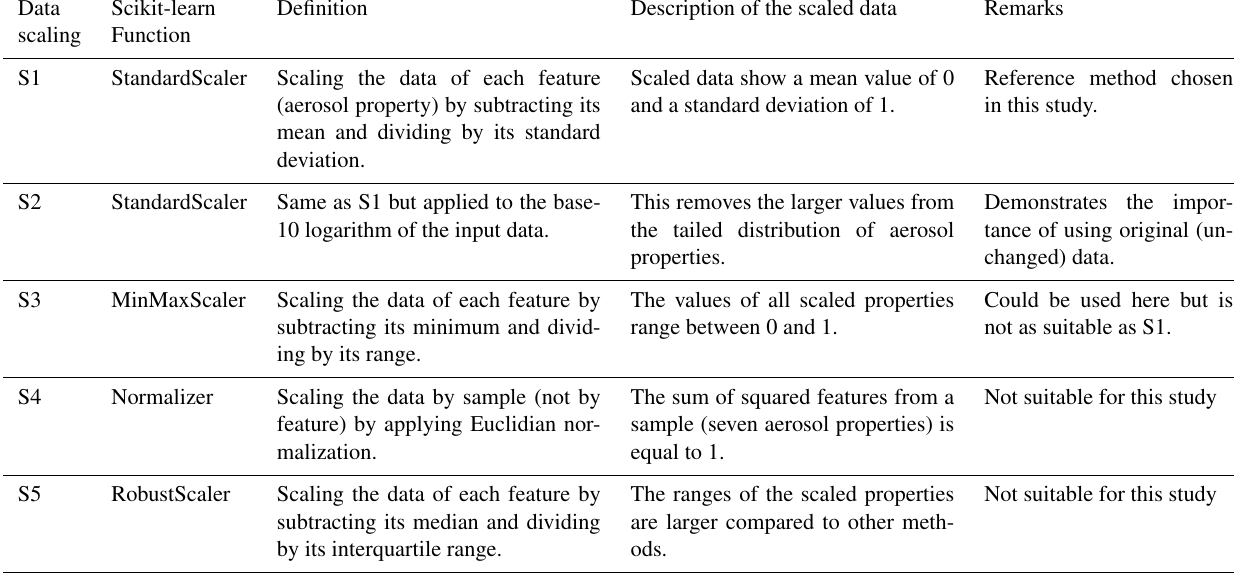
Table 1. Summary of the different scaling methods applied in this